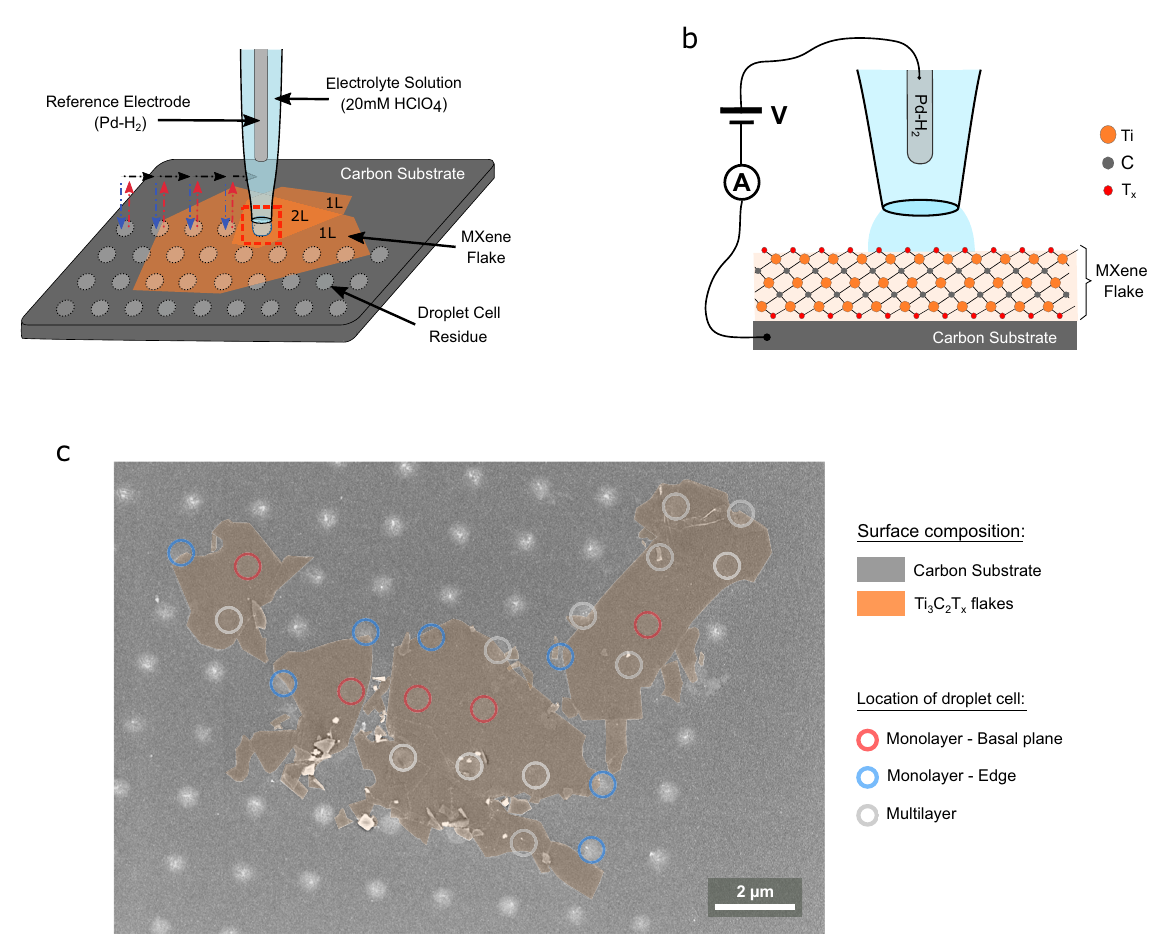
Fig. 1 | Experimental con fi guration used to isolate monolayer MXene pseudo- capacitive responses. a Schematic of the SECCM con fi guration for measuring monolayer Ti 3 C 2 T x fl akes immobilized on a carbon supporting electrode surface. SECCM-based cyclic voltammogram measurements were conducted in a hopping mode, with the probe movement pattern shown in coloured arrows (blue approach, red retract, black move to next measurement position). b Schematic of